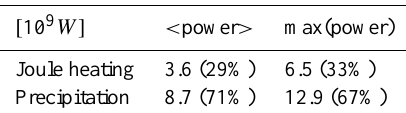
Table 2. Summary of the power dissipated into the ionosphere dur- ing the 15 August 2001